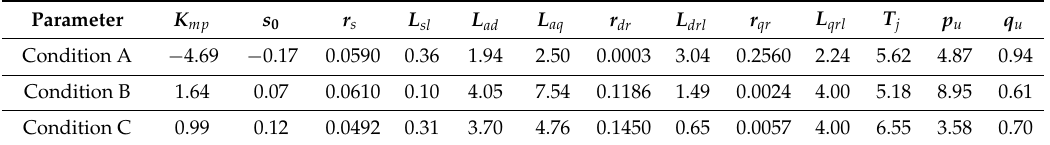
Table 5. Parameter value of different operational conditions.